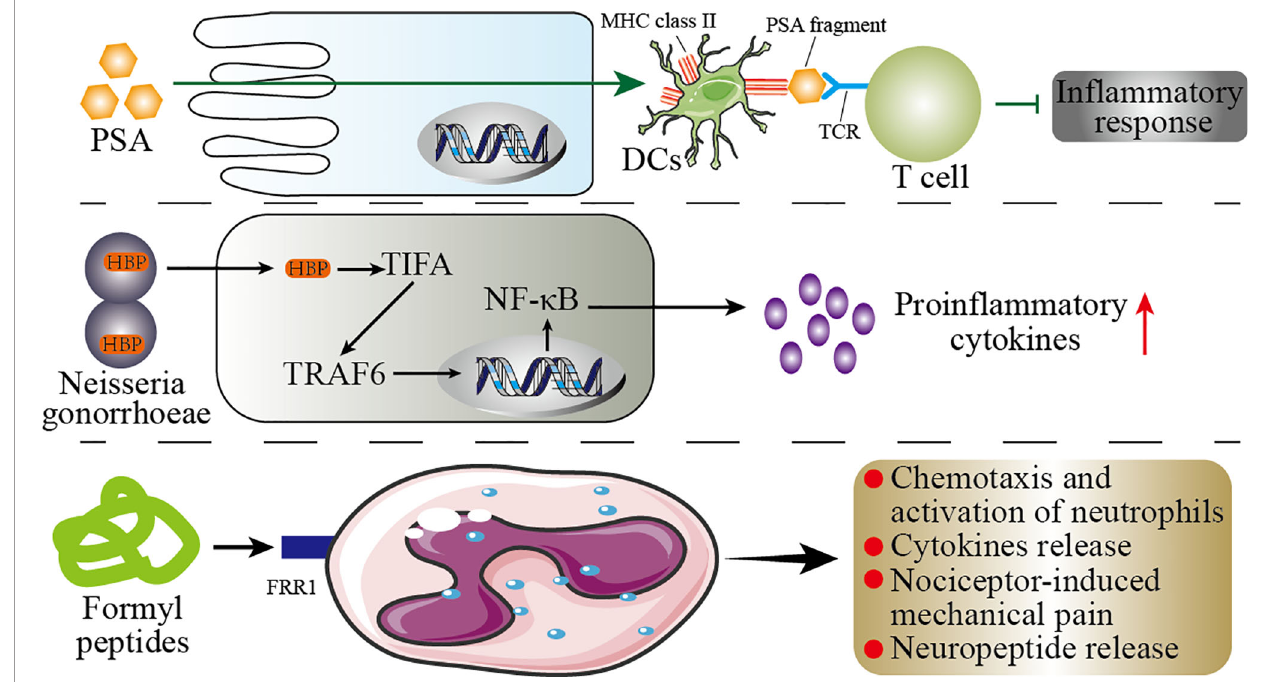
FIGURE 5 | Mechanisms of the microbial components regulating immunity. This fi gure shows the role of the microbial components polysaccharide A (PSA), formyl peptide, and HBP ( D -glycero- b - D -mannoheptose-1,7-bisphosphate) in the host immunity. PSA can enter the circulatory system directly through the host ’ s intestinal epithelial cells (IECs). In the circulatory system, PSA connects dendritic cells (DCs) and T cells through MHC class II and T-cell receptors (TCR) to inhibit in fl ammation. In the host ’ s genitourinary tract, HBP promotes the secretion of proin fl ammatory cytokines by the host ’ s immune cells through the TIFA/TRAF6/NF- k B pathway.